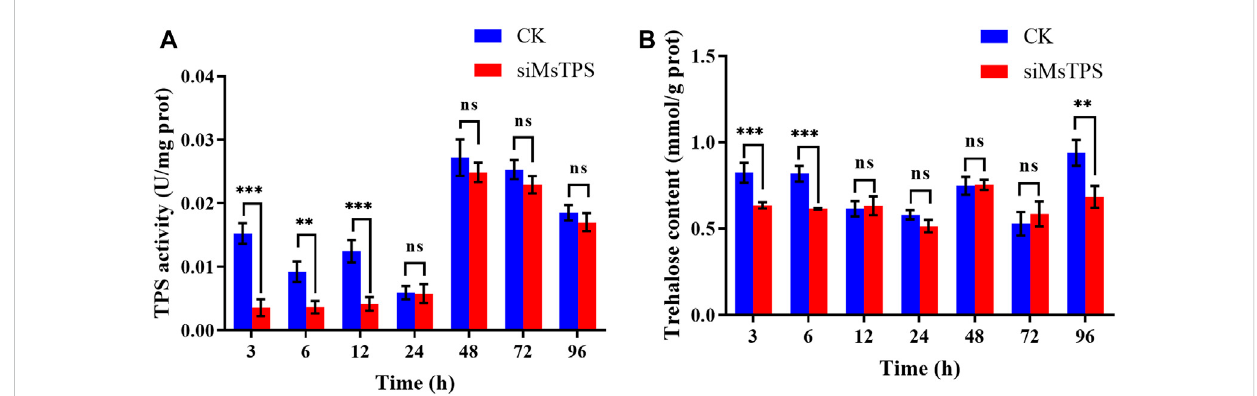
FIGURE 3 M. separata TPS activity (A) and trehalose content (B) at different time-points after the MsTPS RNAi treatment. Data are presented as the mean ± SE. Statistical analyses were performed using the GraphPad Prism software. Statistically signi fi cant differences by t -test at same treatment time shown as asterisks (* p < 0.05, ** p < 0.01, *** p < 0.001, ns > 0.05).